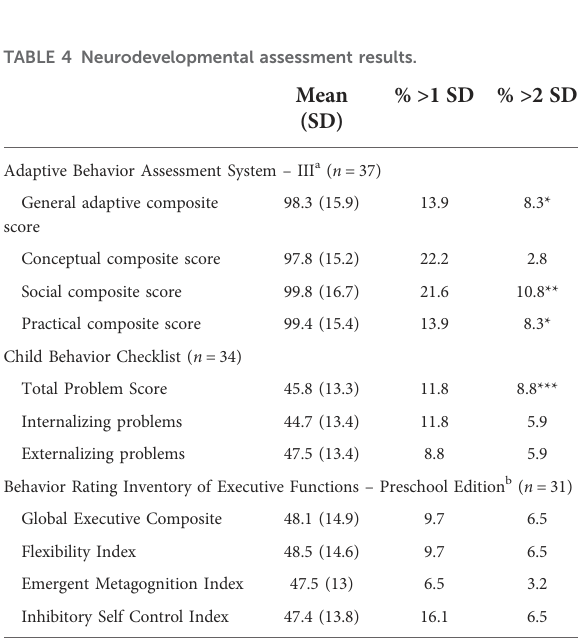
TABLE 4 Neurodevelopmental assessment results.